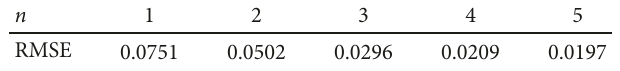
Table 2: RMSE for di ff erent numbers of basis function.